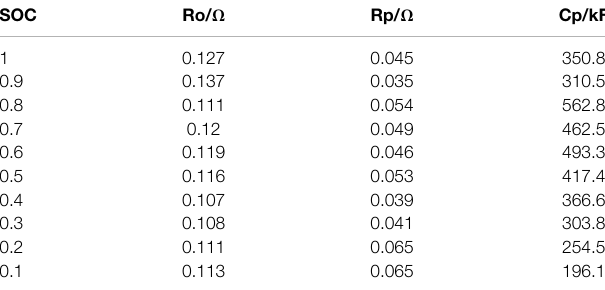
TABLE 2 | Other relevant parameters corresponding to SOC in the model.